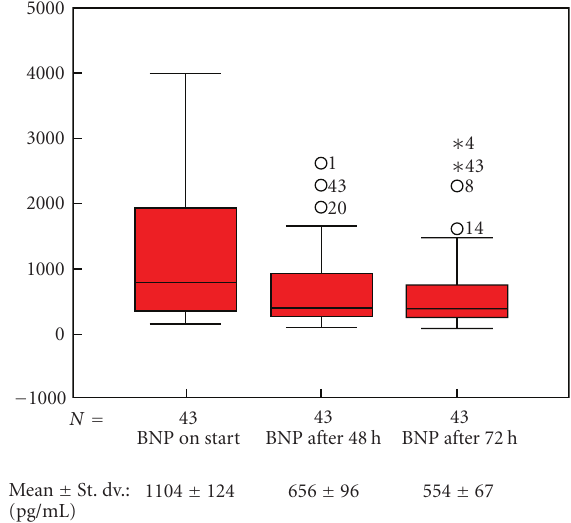
Figure 1: Changes of BNP after onset of levosimendan.